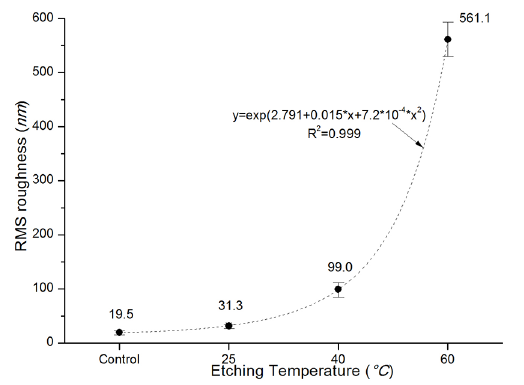
Figure 2. Ti6Al4V RMS roughness changes as a function of etching temperature.